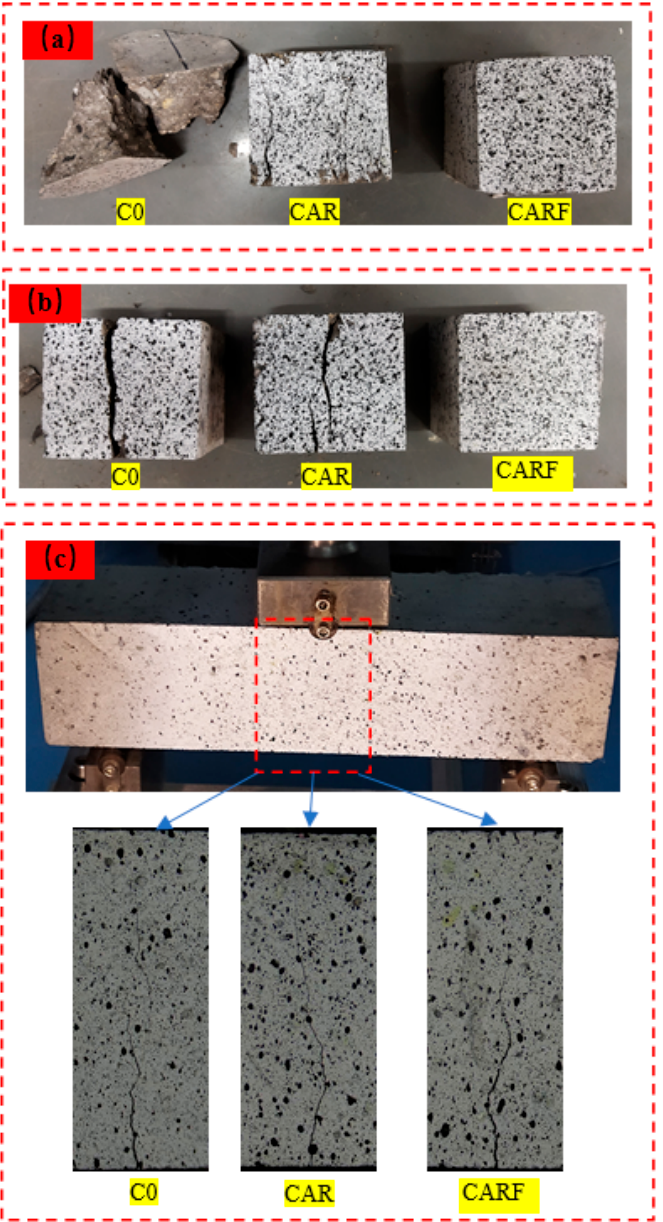
Figure 3. Failure patterns of specimens under ( a ) compressive, ( b ) splitting, and ( c ) three-point bending actions.